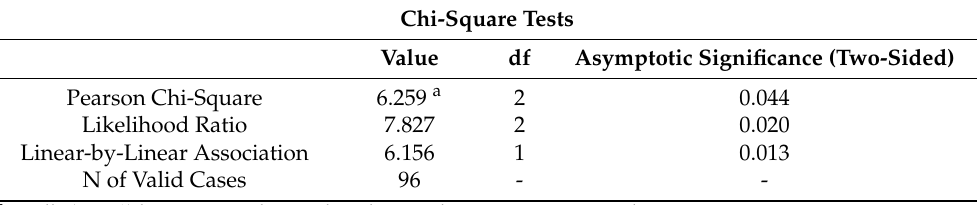
Table 7. Results of Chi-square test for variables role and